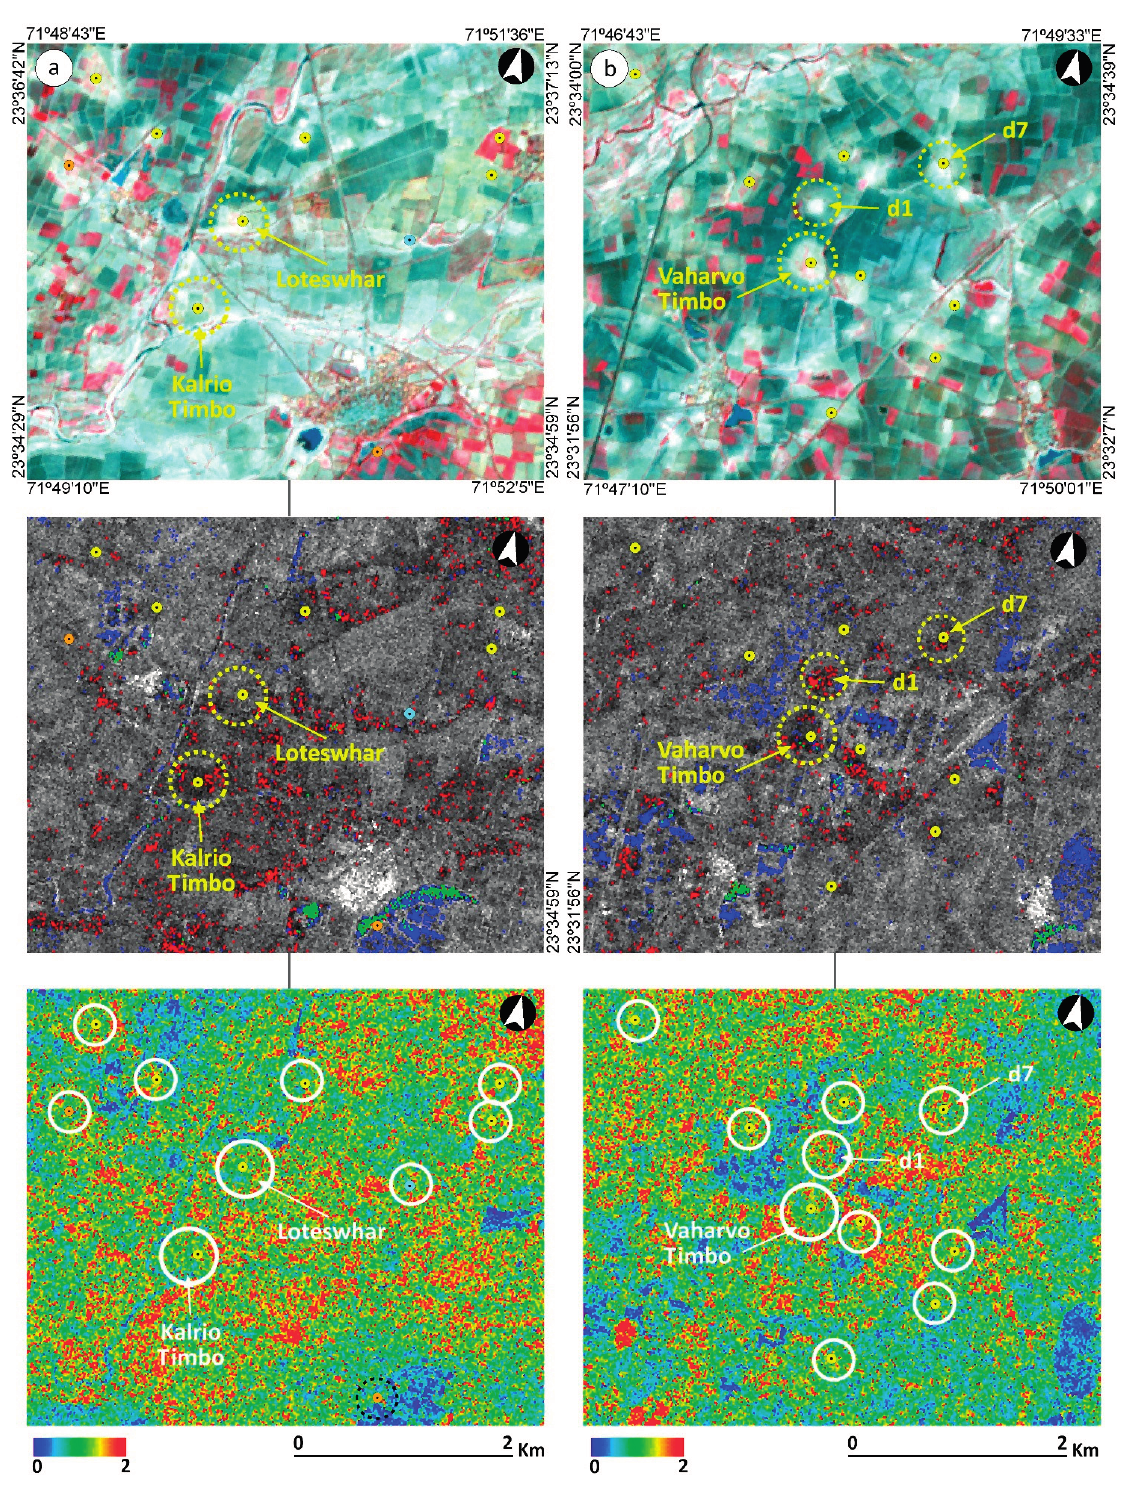
Figure 10. Subset detail of two archaeological areas within the Khari River basin area: ( a ) Loteshwar/Kalrio Timbo and ( b ) Vaharvo Timbo. Image composition shows, in descending order: orthorectified ASTER false colour composite (3N-2-1) from 1 October 2004; integrated seasonal flooding maps (blue for monsoon, red for post-monsoon and green for no change) superimposed to MA images; and seasonal MA change map (stretched